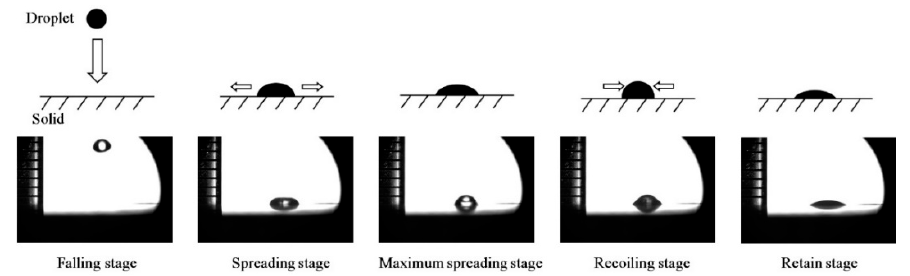
Figure 3. The collision process of between falling droplet and solid surface in five platforms.